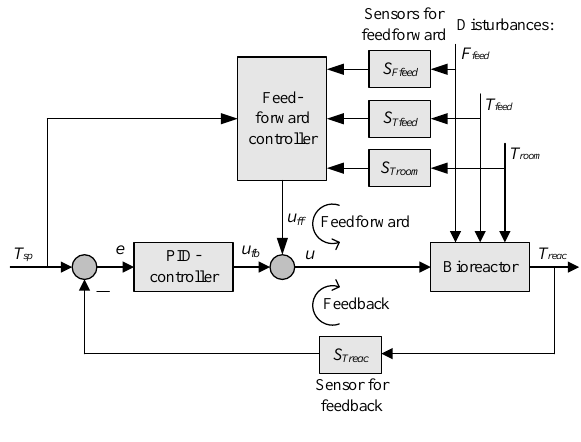
Figure 11: Temperature control system for the bioreac- tor with both feedforward and feedback con- trol.